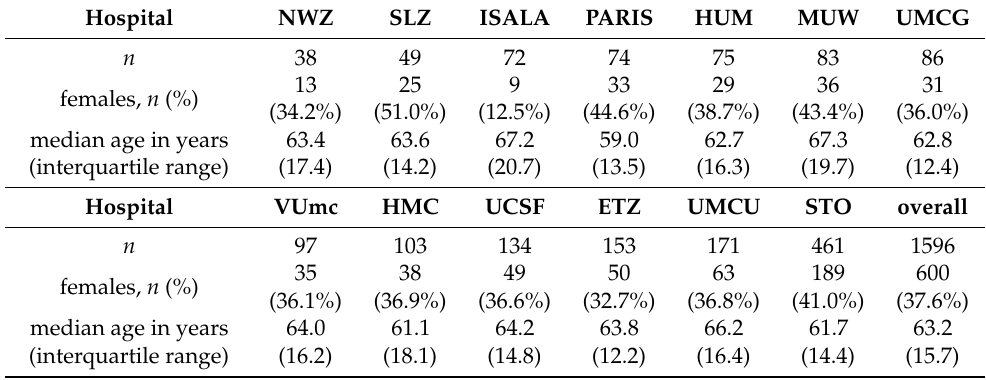
Table 1. Patient